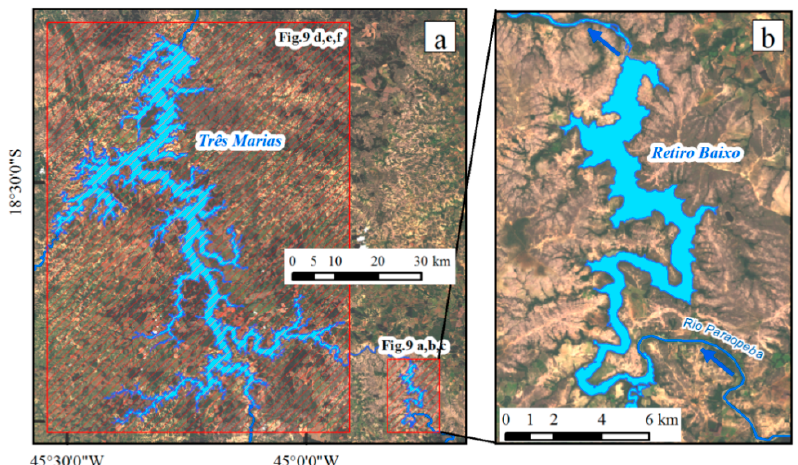
Figure 9. Retiro Baixo and Três Marias reservoirs. The larger reservoir on the left is Três Marias, Figure 9. ( a ) Retiro Baixo and Tr ê s Marias reservoirs. The larger reservoir on the left is Tr ê s Marias, and the smaller one in the lower right corner is Retiro Baixo. and the smaller one in the lower right corner is Retiro Baixo ( b